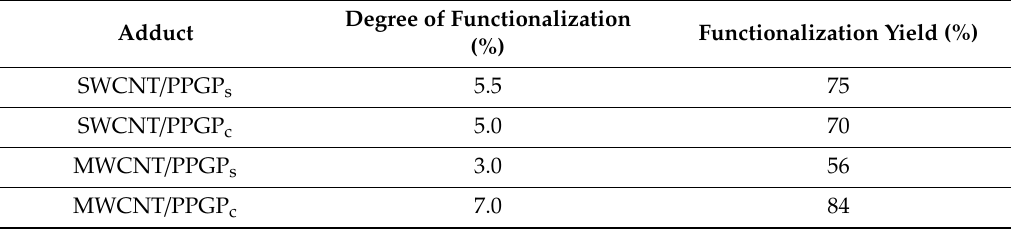
Table 2. Degree a and yield b of functionalization of CNT functionalized with PPGP.